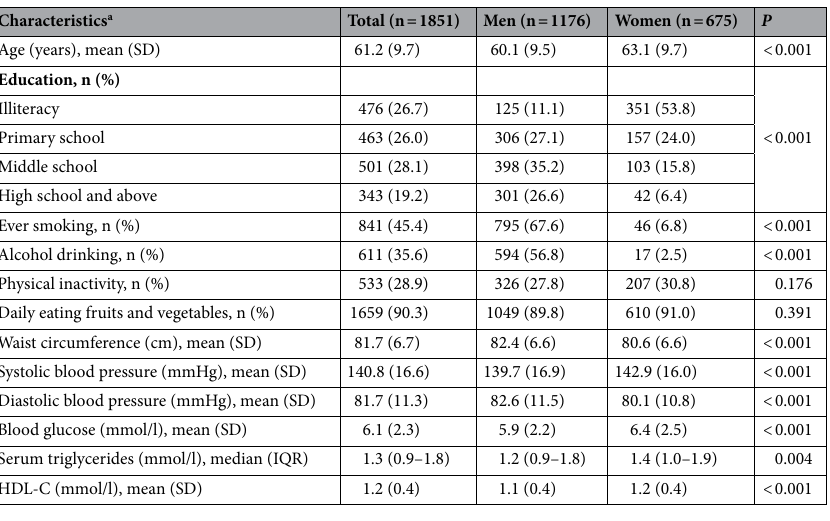
Table 2. Characteristics of study participants by sex. SD standard deviation, IQR interquartile range, HDL- C high-density lipoprotein cholesterol. a The number of missing values was 68 for education, 135 for alcohol drinking, 5 for physical activity, 13 for diet, 51 for waist circumference, 27 for blood pressure, 26 for blood glucose, 34 for serum triglycerides, and 51 for